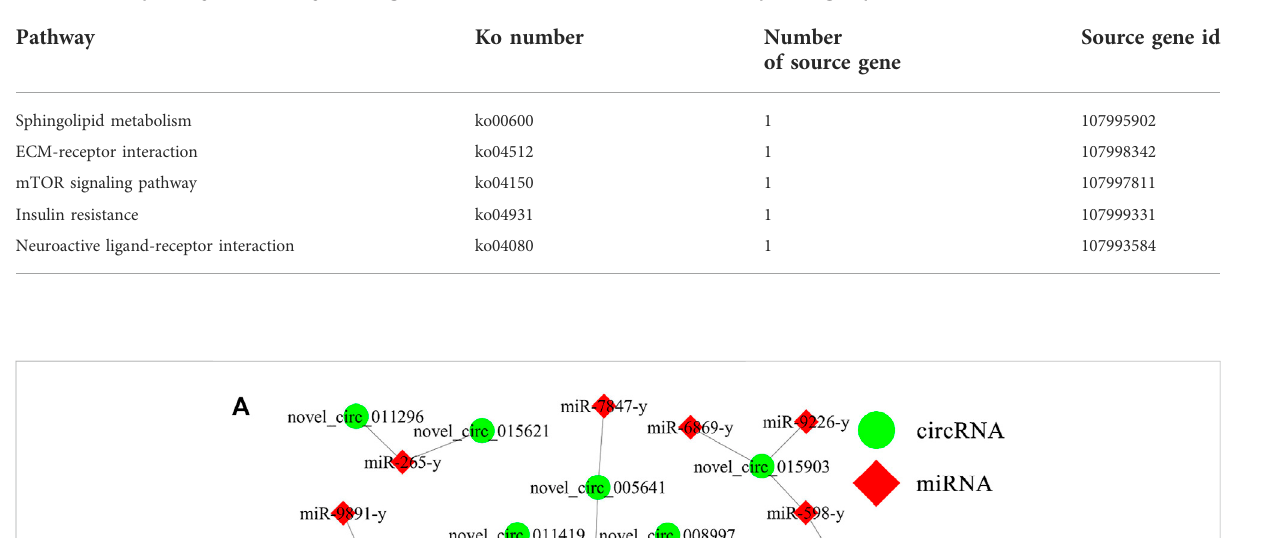
TABLE 3 KEGG pathways enriched by source genes of DEcircRNAs in AcCK2 vs. AcT2 comparison group.